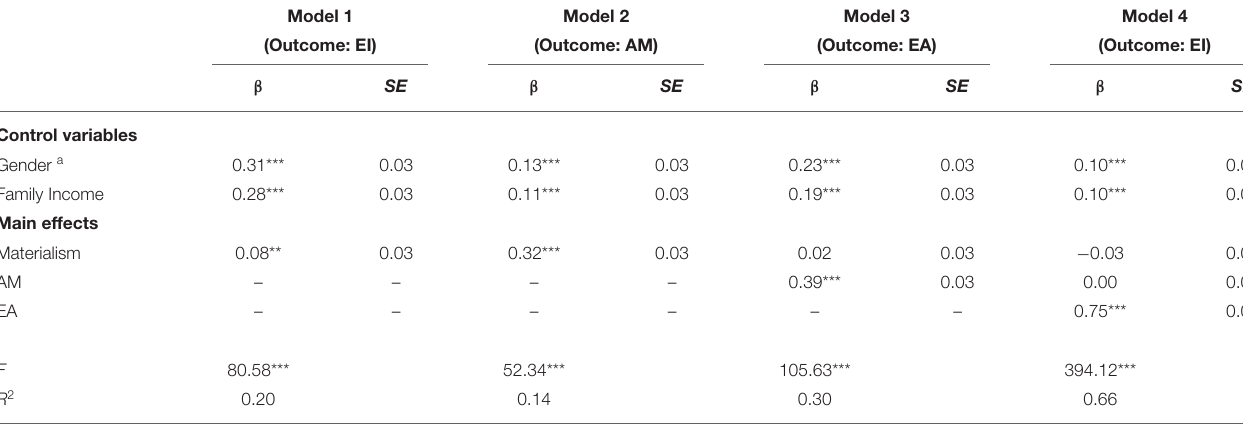
TABLE 4 | Results of the proposed serial mediation model.